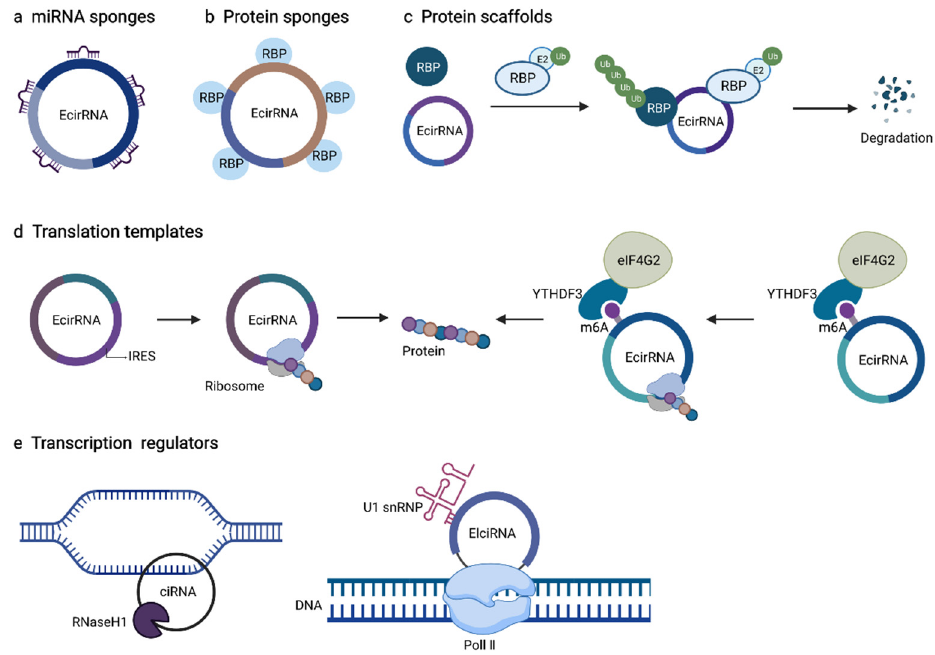
Figure 1. Schematic representations of several biological roles of circRNAs discussed in this article, including exonic circRNAs (EcirRNAs), intronic circRNA (ciRNAs) and exonic-intronic circRNAs (EIciRNAs). ( a ) CircRNAs can function as microRNA (miRNA) sponges or decoys by binding to the miRNA recognition elements (MREs) of miRNAs, thus affecting the expression of miRNA to target mRNA functions. ( b ) CircRNAs can function as key regulators of protein sponges or decoys by competing for the binding to the shared RNA binding protein (RBPs) binding motifs with specific RBPs. ( c ) CircRNAs are able to come into contact with two RBPs, and one of the proteins is often an enzyme such as E3 ubiquitin ligase, that is involved in the ubiquitination progress, which could lead to protein destabilization and degradation. ( d ) CircRNAs with internal ribosome entry site (IRES) elements can be translated to unique peptides. Also, circRNAs contain extensive N6-methyladeno- sines (m6A) modifications. For example, YTHDF3 as the m6A reader and eIF4G2 as translation ini- tiation factor are sufficient to drive protein translation in a cap-independent fashion. ( e ) CircRNAs located in the nucleus can participate in regulating the expression of parental genes. For instance,